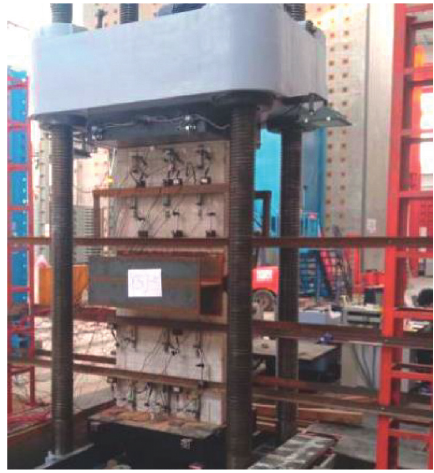
Figure 20: Field loading and testing of the compressive experiment.